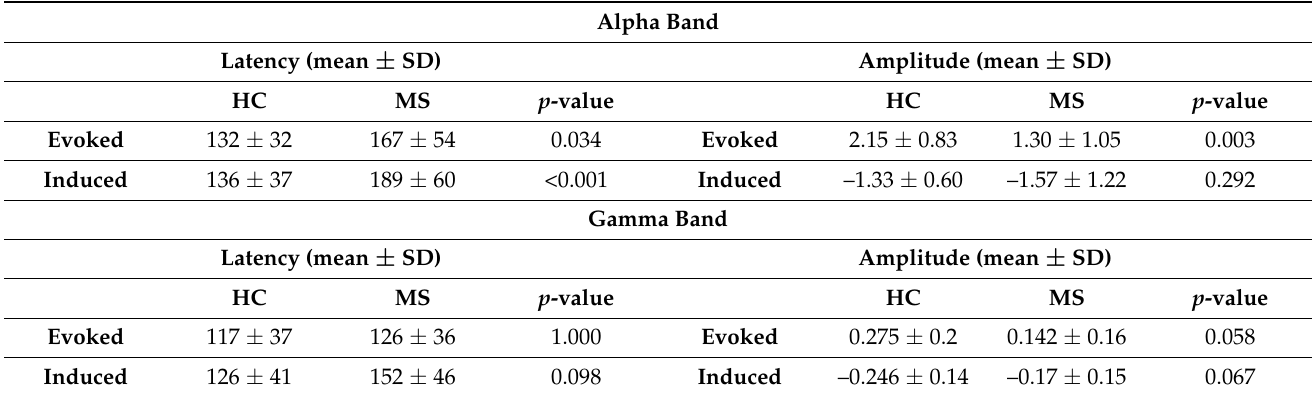
Table 3. Evoked and induced values for alpha band (8–13 Hz) and gamma band (30–45 Hz).